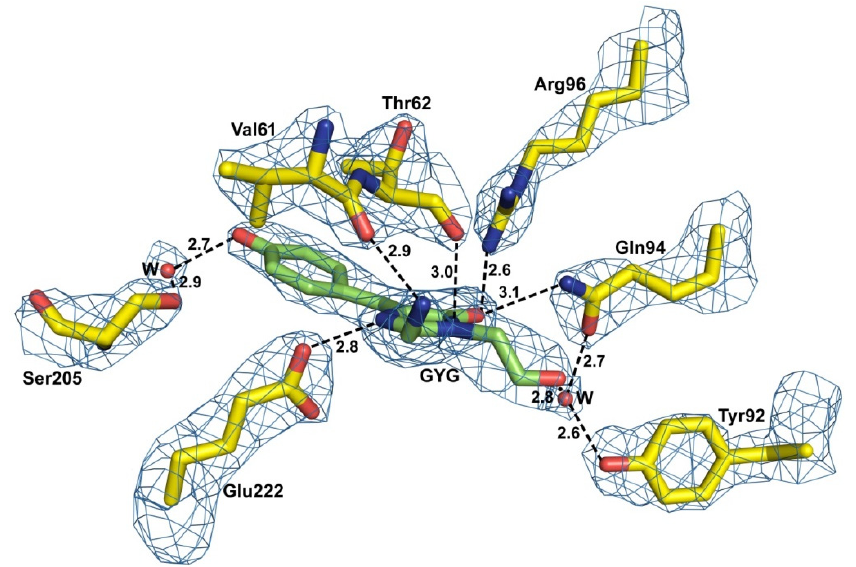
Figure 3. View of the GYG chromophore (shown in green) with key adjacent residues in the 2Fo-Fc electron density (cutoff ρ = 2.0 σ ) Hydrogen bonds ( ≤ 3.3 Å) are shown as black dashed lines and water molecules (W) as red spheres ( fi gure created with PYMOL [12]).